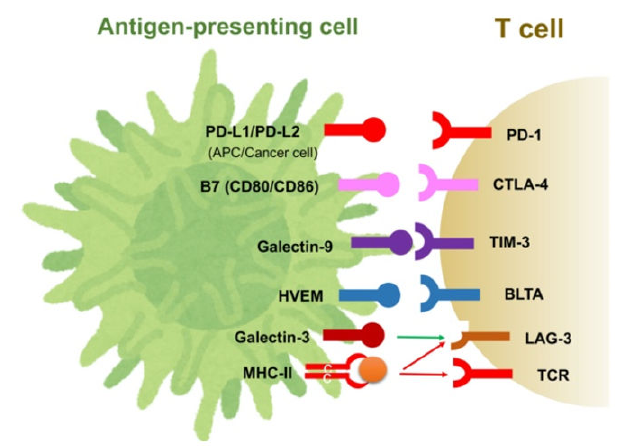
Figure 1. Immune checkpoint molecules and their